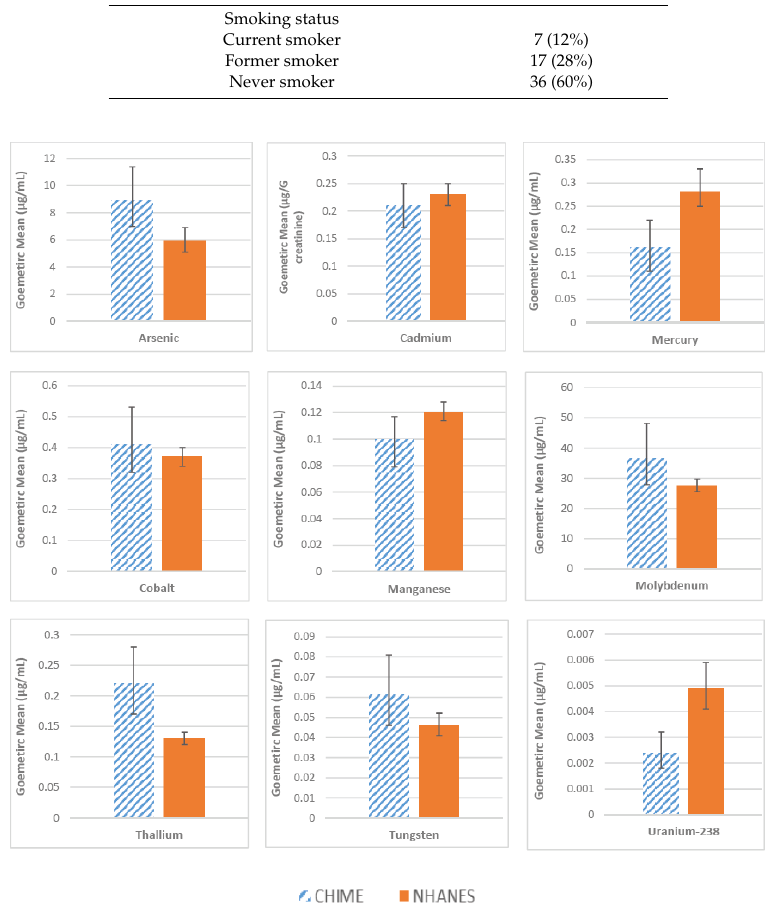
Figure 2. Metal levels in urine among study participants (CHIME), Nevada Country, California, compared to data from the National Health and Nutrition Examination Survey (NHANES) with 95% confidence bars. Table 3. Urinary arsenic and cadmium levels versus answers to survey questions on residential features, diet, and activities.